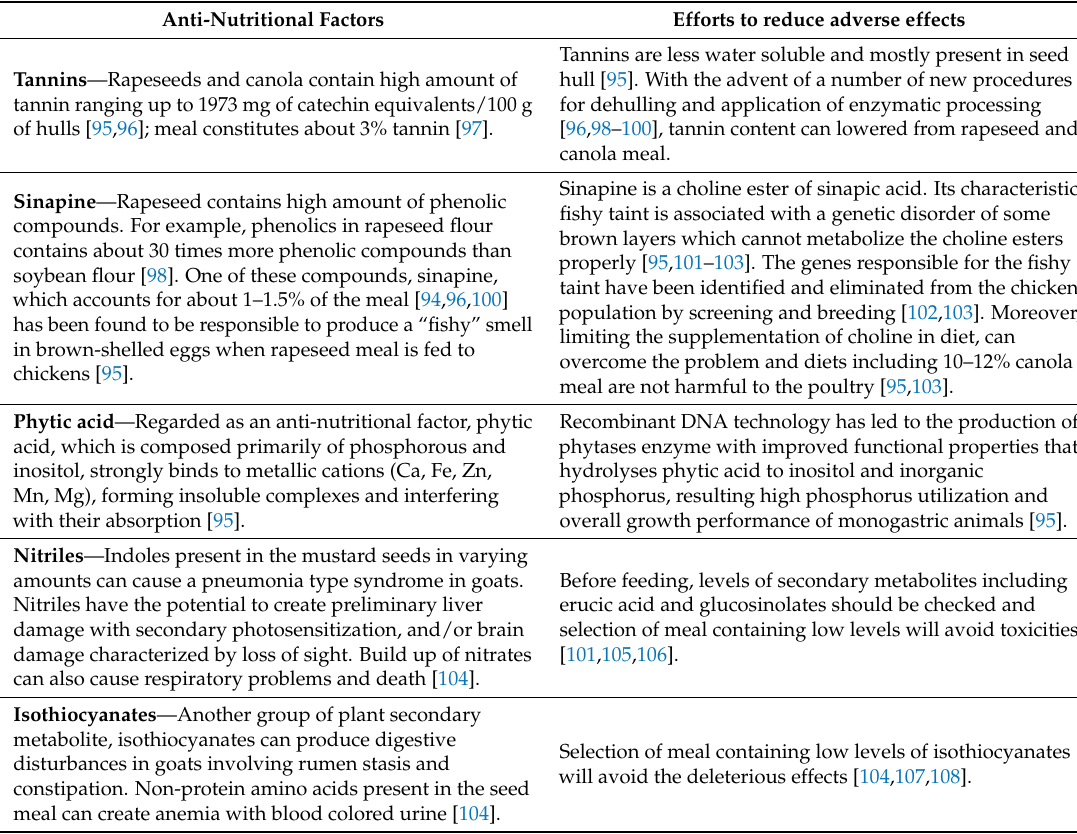
Table 1. Major anti-nutritional factors of canola and mustard